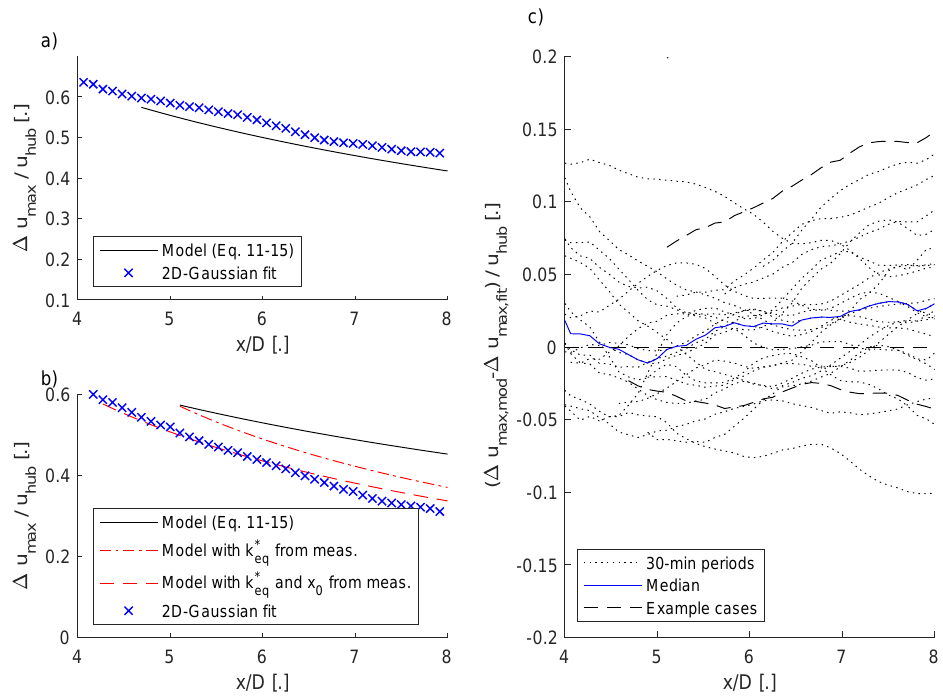
Figure 6. Recovery of the normalized velocity deficit with downwind distance from the wind turbine for the weak wind veer case ( a ) and the strong wind veer case ( b ) introduced in Figure 3. Blue crosses show the maximum velocity deficit estimated from the amplitude of the 2D-Gaussian fit to the lidar measurements. The prediction of the wake model is shown as a black line. The strong wind veer case ( b ) additionally shows the model prediction with the wake growth rate (red dash-dotted line) and near-wake length (red dashed line) estimated from the wake characterization. The right panel ( c ) shows the amplitude error of the model for each 30-min period (black dotted) and the ensemble median (blue line). The two cases of ( a , b ) are highlighted as black dash-dotted lines in ( c ). The median was used, because x 0 > x / d = 4 for some 30-min periods leading to discontinuities in the mean